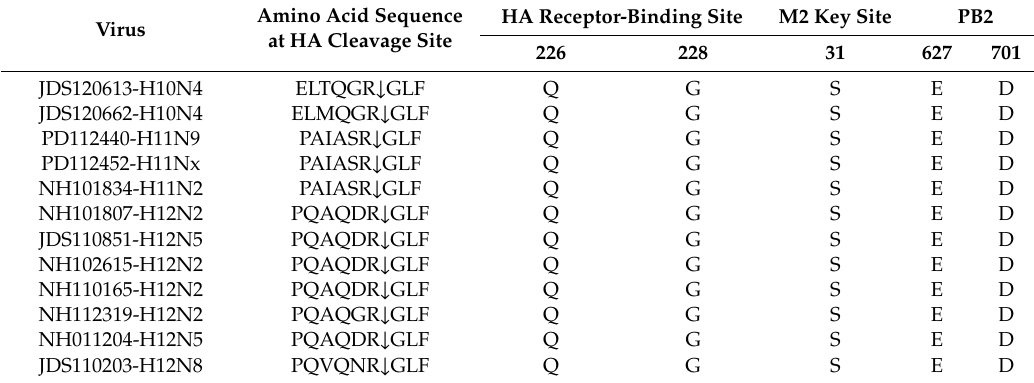
Table 2. Molecular characteristics of the 12 H10–H12